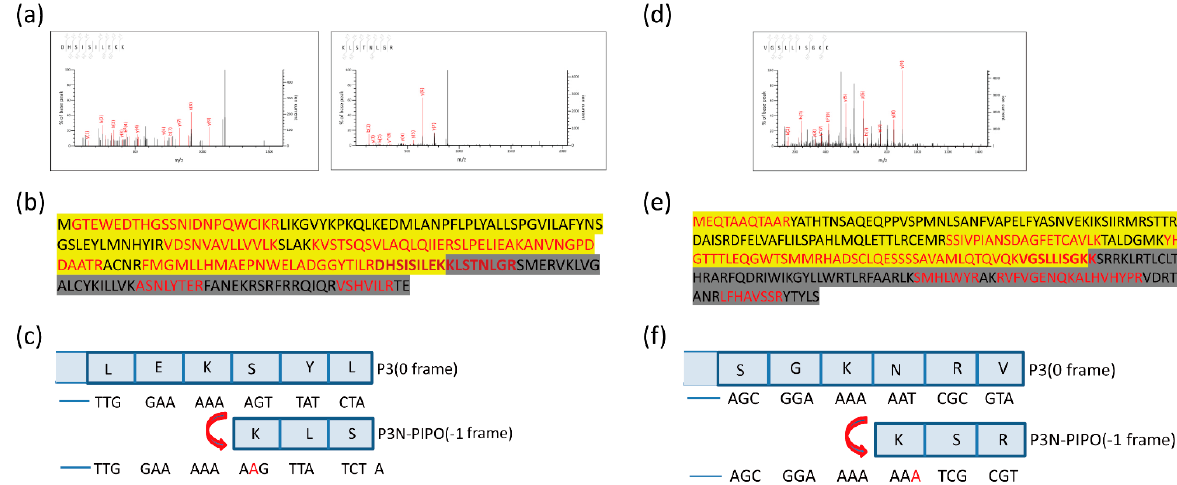
Figure 3. Mass spectrometry of the PVX-TuMV-P3N-PIPO(WT)-GFP and PVX-WYMV-P3N-PIPO(WT)-GFP frameshift expression proteins. ( a ) MS/MS fragmentation spectra of the shift site peptides DHSISILEKK and KLSTNLGR in TuMV-P3N-PIPO(WT). ( b ) The complete amino acid sequence of TuMV P3NPIPO. The peptides before the G 2 A 6 site are highlighted in yellow. Amino acids encoded by the –1 frame are highlighted in dark. ( c ) Nucleotide sequence around the G 2 A 6 shift site, and conceptual amino acids translated in the 0 and –1 reading frames in TuMV-P3N-PIPO. ( d ) MS/MS fragmentation spectrum of the shift site peptide VGSLLISGKK in WYMV-P3N-PIPO(WT). ( e ) The complete amino acid sequence of WYMV P3NPIPO. The peptides before the G 2 A 6 site are highlighted in yellow. Amino acids encoded by the − 1 frame are highlighted in dark. ( f ) Nucleotide sequence around the G 2 A 6 shift site, and conceptual amino acids translated in the 0 and − 1 reading frames in WYMV-P3N-PIPO.